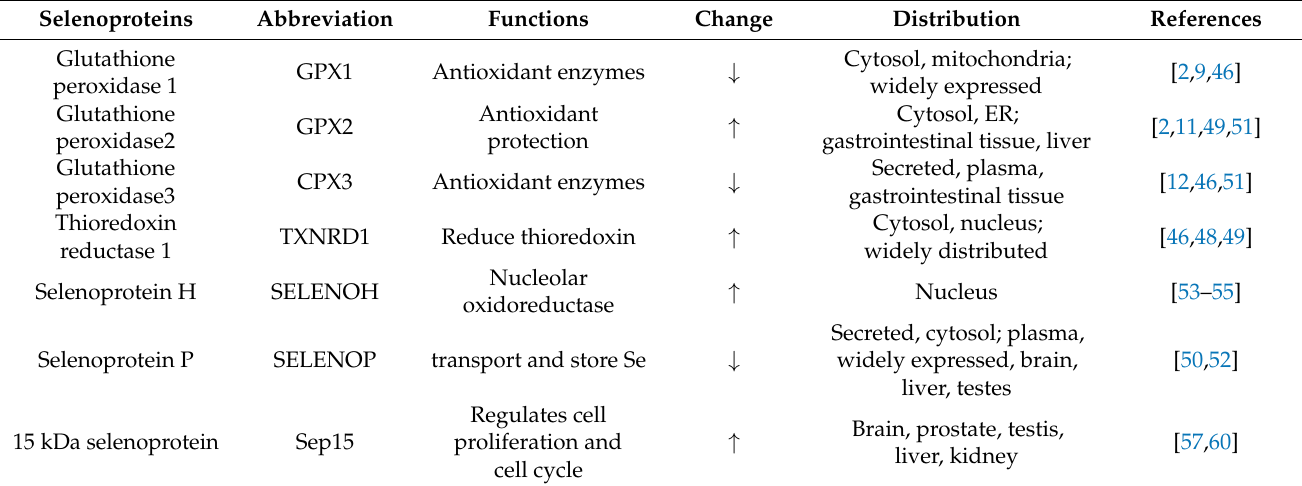
Table 2. Function of selenoproteins associated with intestinal